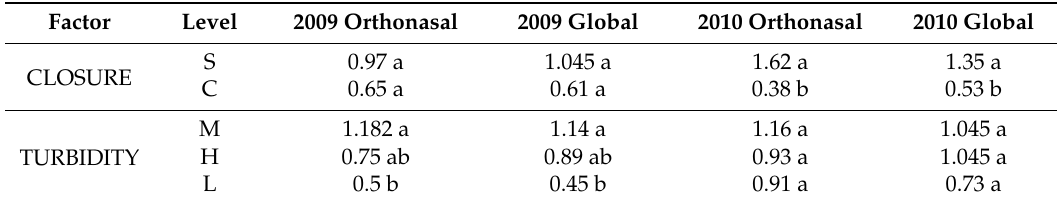
Table 4. Results of the post-hoc Newman-Keuls’ tests ( α = 0.05) on the REDOX odor intensities comparing the two closure types and the three turbidity levels for each vintage and each evaluation condition. S: synthetic coextruded stoppers; C: screw cap stoppers. L: low; M: medium; H: